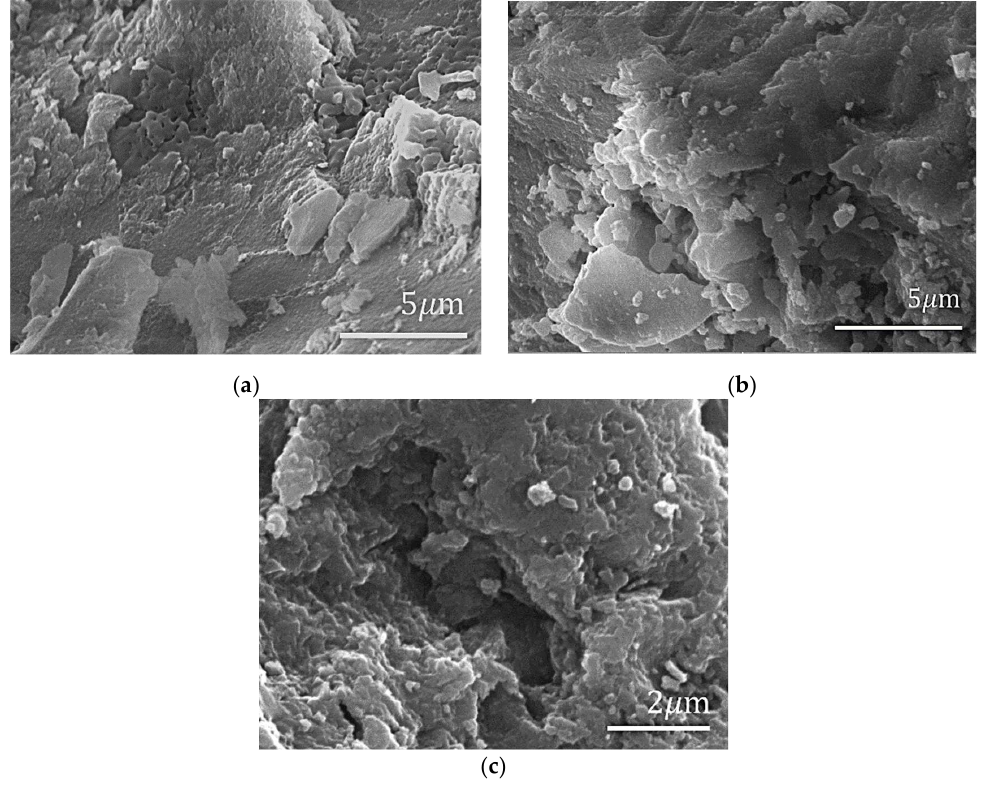
Figure 2. SEM micrographs of ( a ) ZnAl 2 O 4 : Mn annealing at 1200 ℃ ; ( b ) ZnAl 2 O 4 : Mn annealing at 1300 ℃ ; ( c ) ZnAl 2 O 4 : Mn annealing at 1400 ℃.